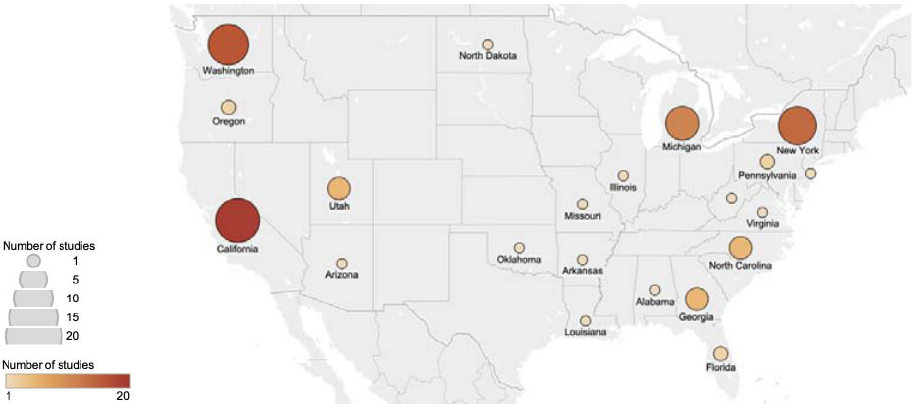
Figure 2. ( a ) Geographical distribution of cover crop field research conducted in perennial agro-ecosystems, indicated by the number of published peer-reviewed articles per country; ( b ) due to the high research coverage in the United States, the research distribution is presented by state.